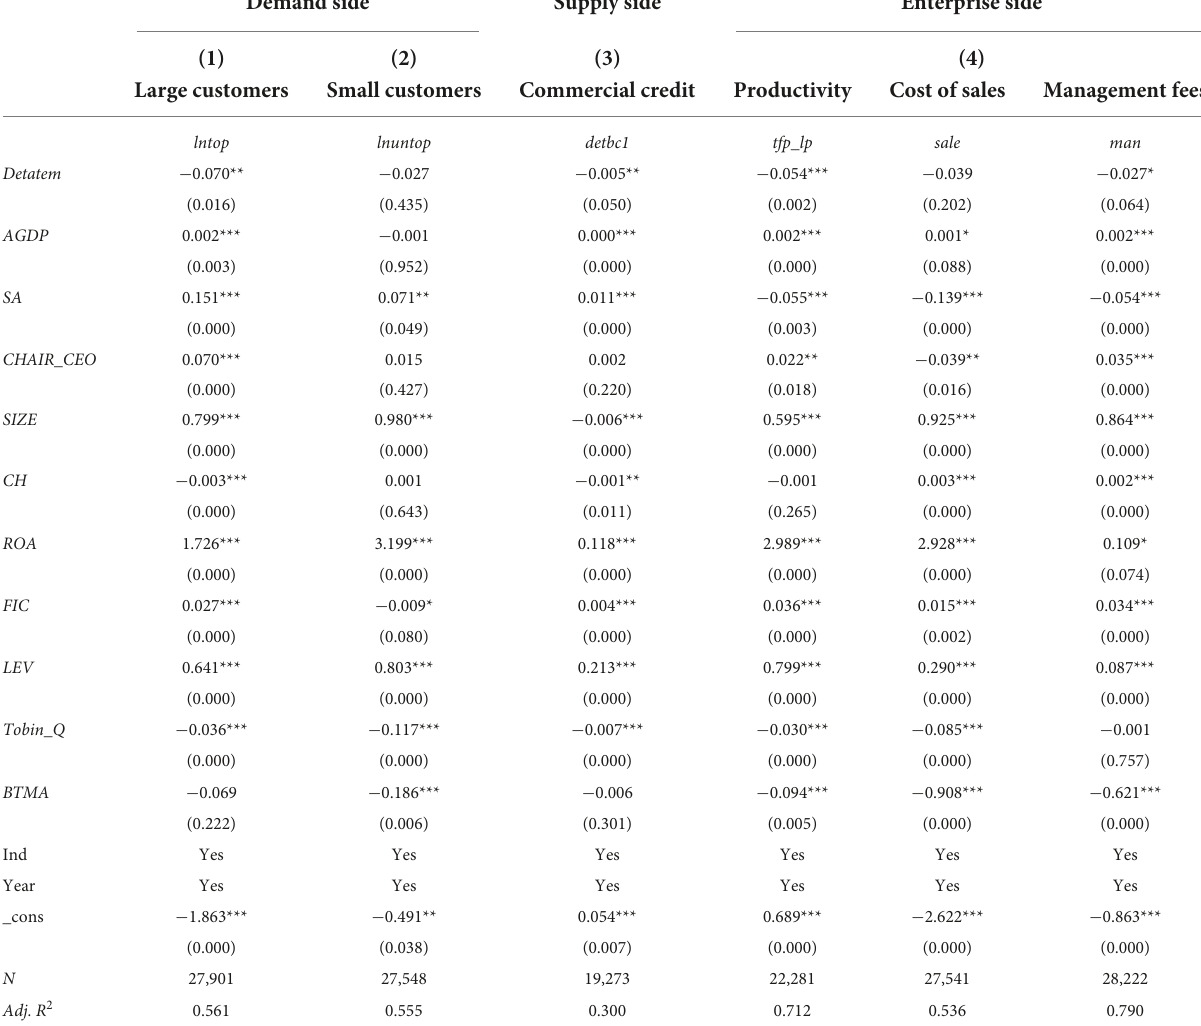
TABLE 8 Regression results for the mechanism of